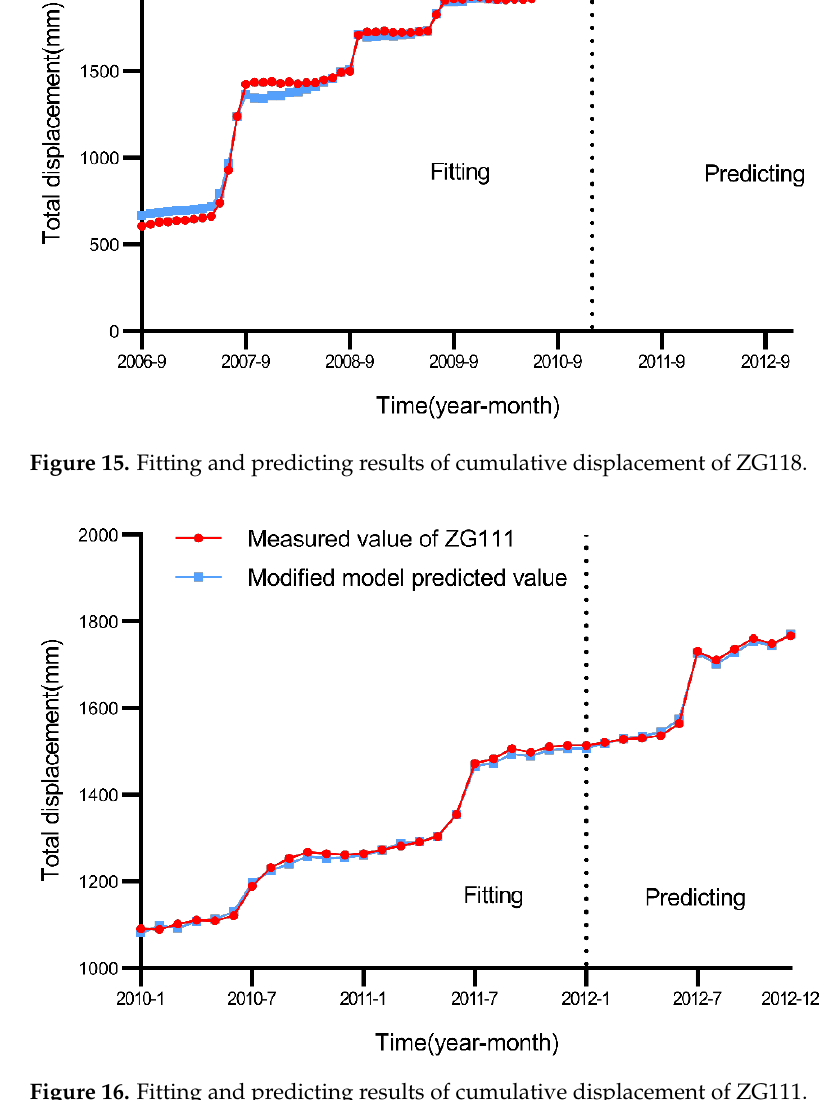
Figure 16. Fitting and predicting results of cumulative displacement of ZG111.